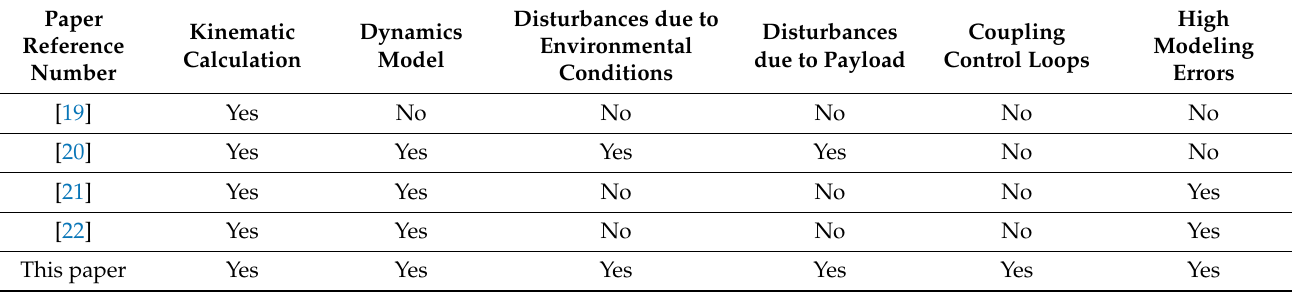
Table 1. Control model parameter